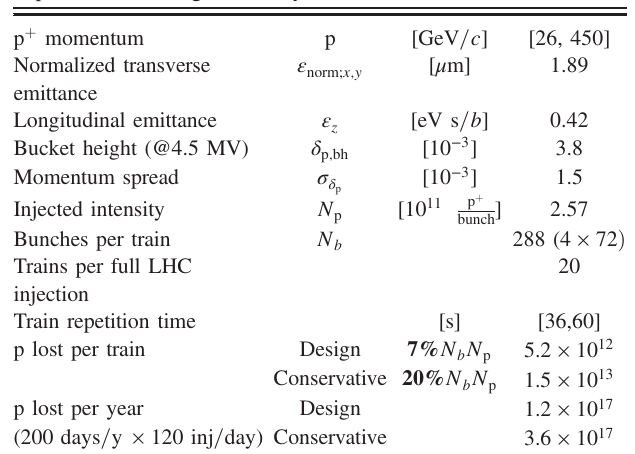
TABLE II. Relevant parameters of HL-LHC beams in the SPS [3,10]. Parameters depending on the beam energy correspond to the SPS injection energy. The design loss scenario corresponds to the overall budget minus the contribution from scraping at the flattop. The conservative loss scenario is defined based on experience with high intensity beams [11].